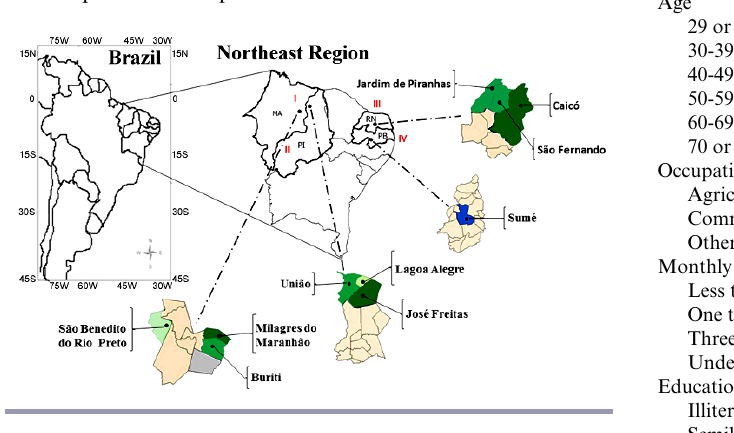
Fig. 1 . Map showing the studied area. MA = State of Maranhão (I); PI = State of Piauí (II); RN = State of Rio Grande do Norte (III); and PB = State of Paraíba (IV), and their respective municipalities.